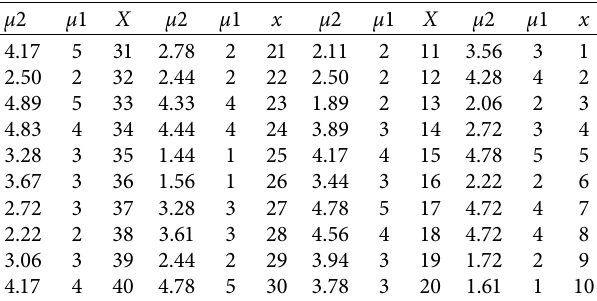
Table 7: System output results in expert output of actual data.